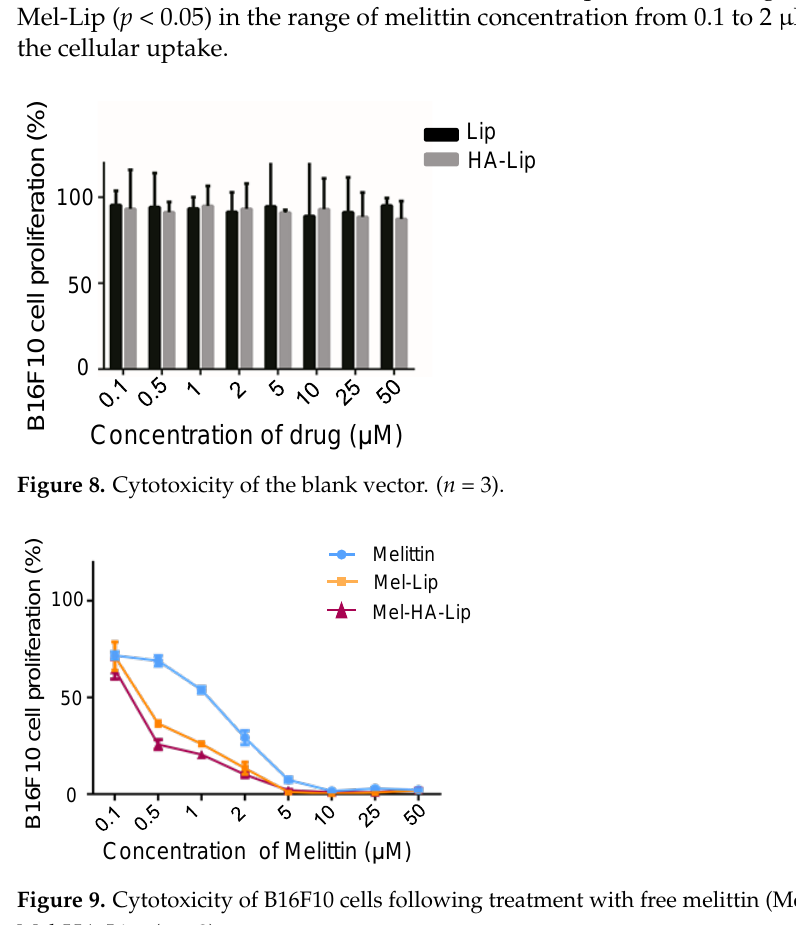
Figure 7. Mean fluorescence intensity of B16F10 cells following treatment with C6-Lip and C6-HA-